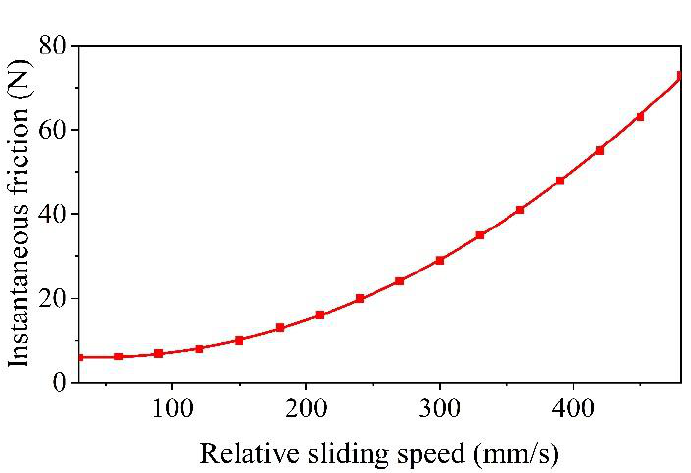
Figure 3. Fitting curve of viscous resistance growth of a nitrile rubber with relative sliding velocity under the condition of a specific compression ratio and surface roughness. The springback law of the sleeve is explored with different inclination angles and spring stiffnesses of the corer under the action of the frictional resistance of the O-ring. The springback model is equivalent to a quadratic parabolic single-degree-of-freedom vibration model with a variable damping coefficient. The sleeve moves under the combined action of its own gravity, the elastic force, and the O-ring frictional resistance. Comparing the spring drive with the general fixed damping ratio, the spring model with a variable damping coefficient of quadratic parabola had a better effect on speed control. Its vibration equation is as follows: